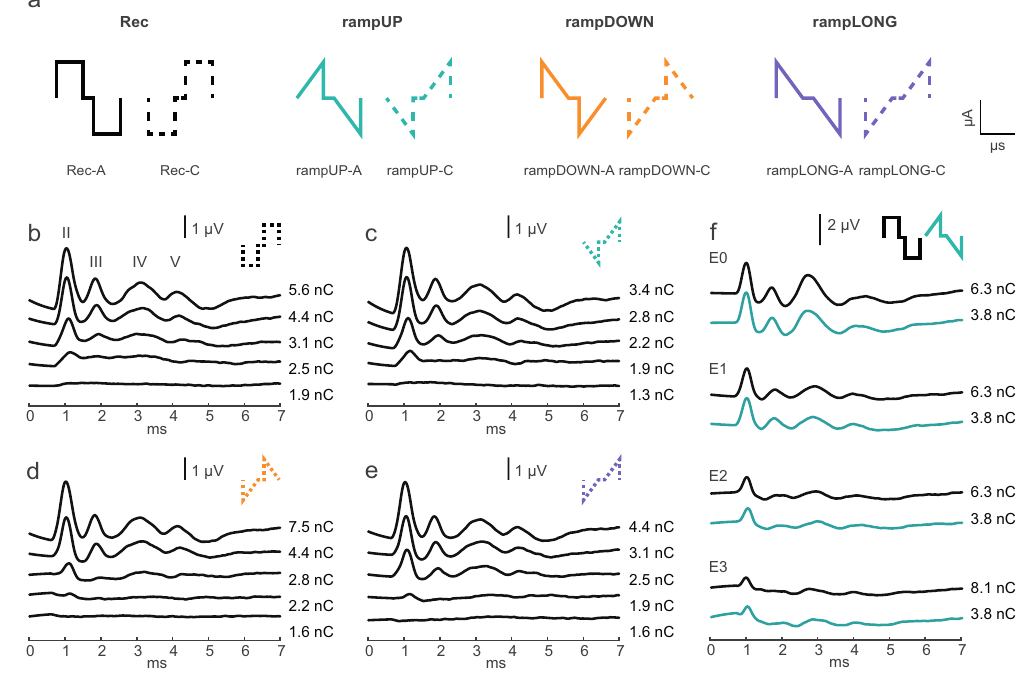
Figure 1. Ramped pulses can evoke eABRs. ( a ) Pulse shapes used. Pulses were charge-balanced and biphasic with 25 μ s/phase and a 10 μ s interphase gap. Rectangular (Rec) and ramped (Ramp) pulses are shown from left to right. The polarity of the first phase is indicated by -A (anodic) or -C (cathodic), respectively. ( b–f ) Representative eABR response traces to increasing stimulation level on E0 (the most apical electrode) to ( b ) rectangular, ( c ) rampUP, ( d ) rampDOWN, and ( e ) rampLONG, all with cathodic-first polarity (mouse M2). ( f ) Example responses to Rec (black) and rampUP (green) on all four intracochlear electrodes, both with anodic- first polarity (mouse M7). The amount of injected charge used is written at each trace level. Time 0 ms is defined as onset of the stimuli artefact (removed by linear interpolation). eABR waves are denoted by roman